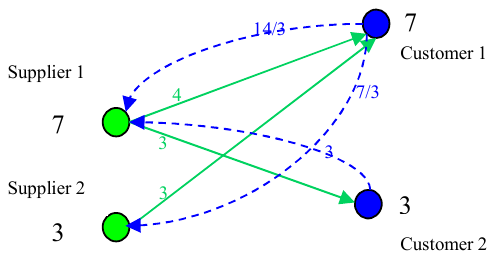
Figure 10. The case of self-organizing optimization.